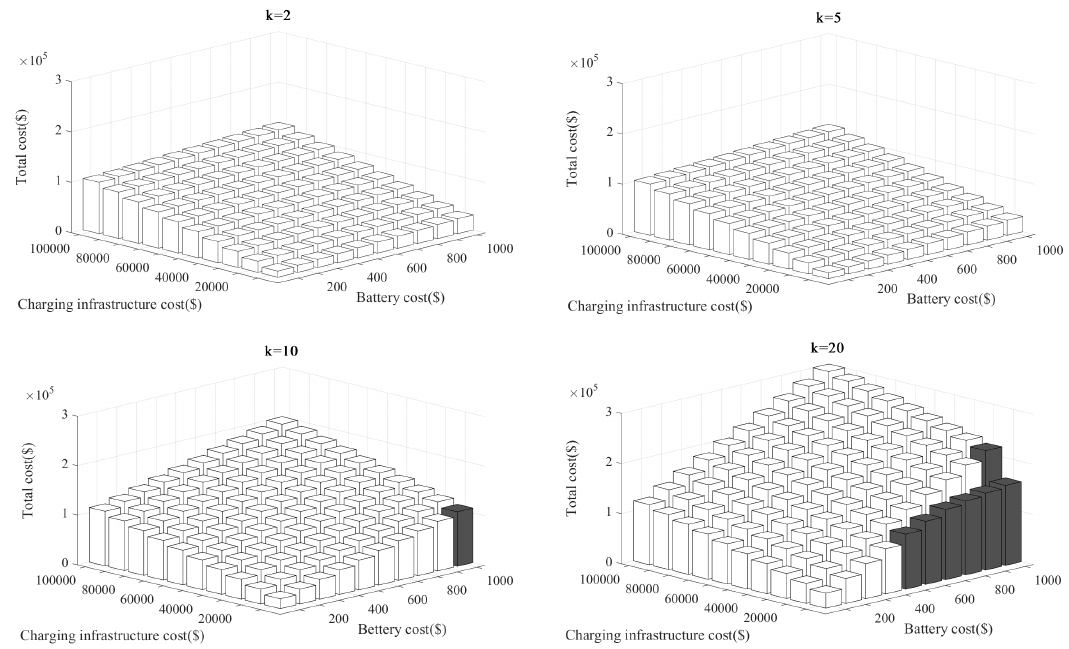
Figure 12. Cost comparison of EV types for the KAIST case (white region: SWC is competitive; gray region: QWC is competitive; black region: DWC is competitive).